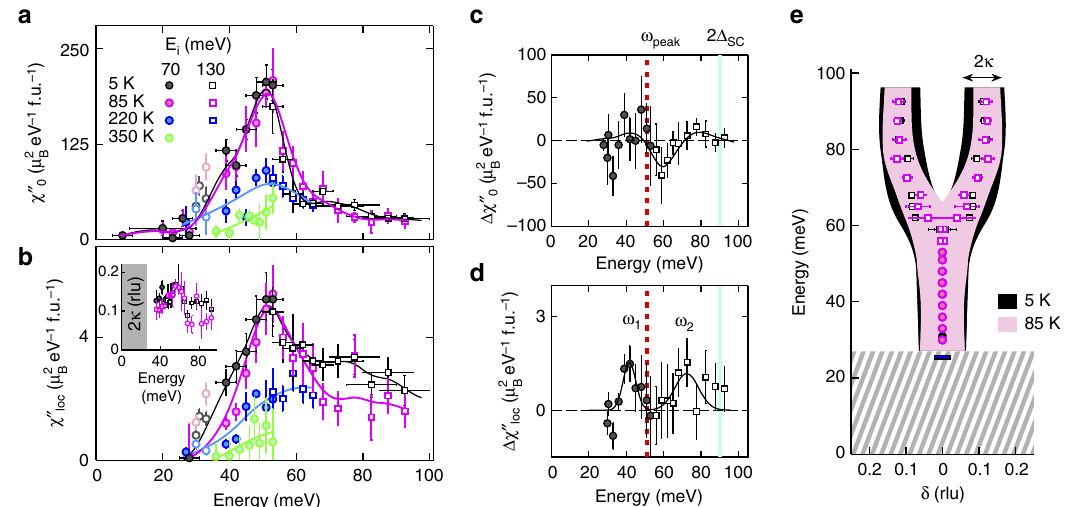
Figure 3 | Magnetic susceptibility amplitude and local susceptibility for HgUD71. ( a ) Energy dependence of the measured peak magnetic susceptibility w 00 0 at T ¼ 300, 220, 85 and 5K. Closed circles: E i ¼ 70meV. Open squares: E i ¼ 130meV. Solid lines: guides to the eye. Horizontal bars for the 5K data represent energy bins. The same binning is used at higher temperatures. Between 30 and 33meV the data are systematically contaminated by aluminium and phonon scattering, and are represented as lighter open symbols (see Supplementary Fig. 3). ( b ) Same legend as a . Energy dependence of the momentum-integrated (local) susceptibility w 00 loc . In determining w 00 loc , we assume that AF fluctuations are quasi-two-dimensional, that is, that w 00 does not depend on L . Inset: 2 k (FWHM) as a function of energy at 5K (black) and 85K (magenta). ( c , d ) Change of w 00 and w 00 loc , respectively, between 5 and 85K 0 (that is, across T c ). Filled and open symbols: E i ¼ 70 and 130meV, respectively. The red vertical line marks o peak . The turquoise line represents 2 D SC , where D SC ¼ 45 ± 1meV is the maximum SC d- wave gap determined from Raman scattering 33 . Black line in c : guide to the eye. Black line in d : fit to two Gaussian peaks, located at o 1 ¼ 44 ± 2meV and o 2 ¼ 75 ± 2meV. ( e ) Energy dependence of incommensurability d at 5K (black) and 85K (red). Horizontal error bars are fit uncertainties for d . For o o 59meV, the data are best described with d ¼ 0. We estimate an upper bound of d E 0.03, which is the approximate value of the instrumental momentum resolution in the o ¼ 27–59meV range. Shaded black and magenta regions represent 2 k at 5 and 85K, respectively. Hatched area indicates the gap D AF . Horizontal blue bar at o ¼ 27meV represents the instrumental momentum resolution at that energy for E i ¼ 70meV. All vertical error bars in figure are least-square fit errors (1 s.d.).